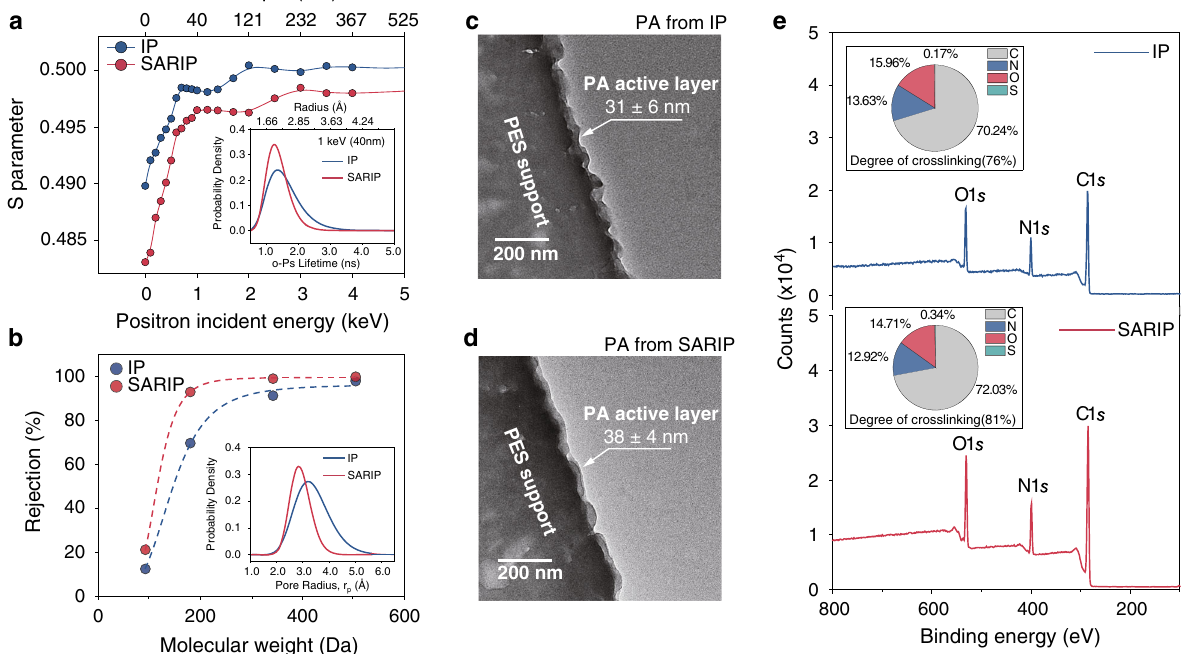
Fig. 2 Properties of the PA active layers from IP and SARIP. a Evolution of S parameters for the PA active layers obtained using IP (blue circles and curve) and SARIP (red circles and curve). Inset: free-volume size distribution of PA active layers derived from the annihilation lifetime distribution of ortho- positronium (o-Ps) with incident energy of 1 keV. b Rejections of uncharged model solutes including raf fi nose, sucrose, glucose, and glycerol by TFC-PA membrane obtained from IP (blue circles and dashed curve) and SARIP (red circles and dashed curve). Inset: pore size distribution of PA active layers derived from rejection curves of uncharged solutes 28 . c , d TEM images of the cross-sections of the PA membranes fabricated using IP and SARIP, respectively. The translucent fi lm in each image is the PA active layer and its thickness is analyzed using ImageJ at eight different locations. The reported PA layer thickness represented the average of eight measurements and the error bar represents the standard deviation of eight measurements. e XPS spectra and the corresponding elemental compositions (insets) of PA active layer for TFC-PA membranes fabricated using IP (top) and SARIP (bottom), respectively. The degree of crosslinking (shown in insets) is determined based on the ratio between elements O and N 29